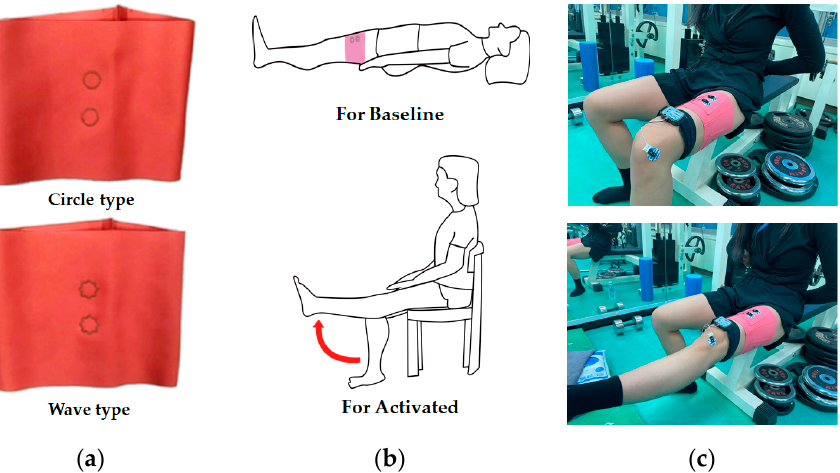
Figure 4. Images for measurement for sEMG signal: ( a ) actual leg sleeve; ( b ) testing posture; ( c ) actual sEMG signal testing.